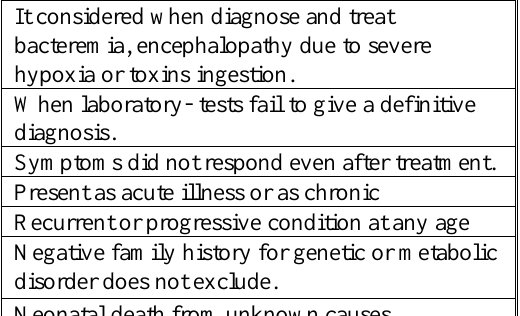
Table 1 . Primary care physician guidelines for IEM diagnosis